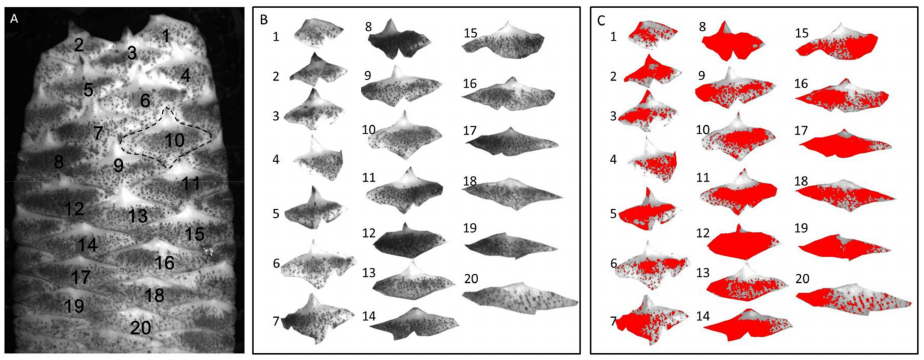
Figure 6. Scale numbering ( A ), scale matting ( B ), and wounding area quantification ( C ) of C.